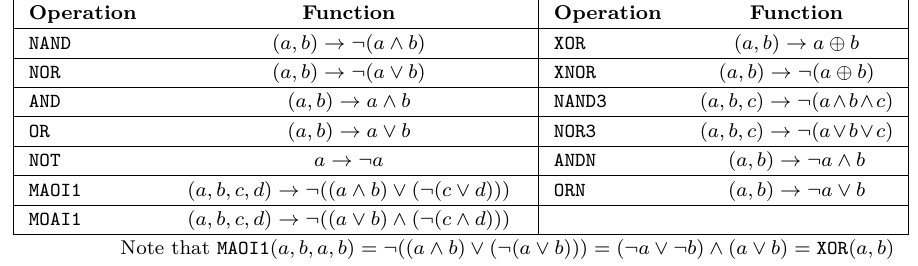
Table 2: List of atomic operations implemented by standard cells from the libraries, recall that ∧ , ∨ , ⊕ , ¬ respectively stand for: logical and, or, exclusive or, not. [JPST17])